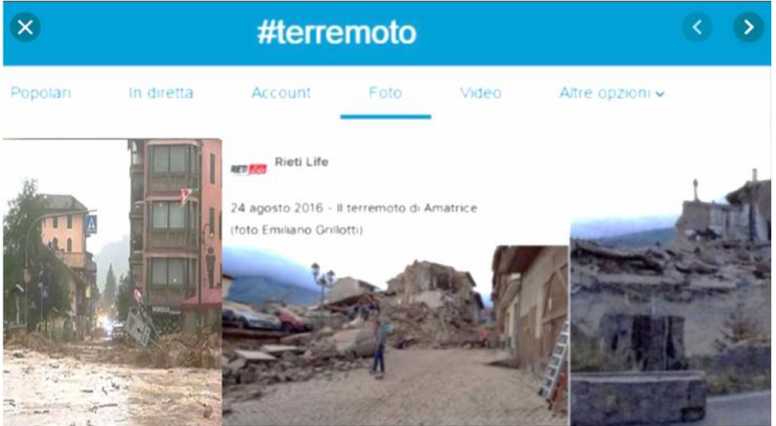
Figure 8. Three different images retrieved from Twitter during the Italian earthquake in 2016 (#terre- moto means #